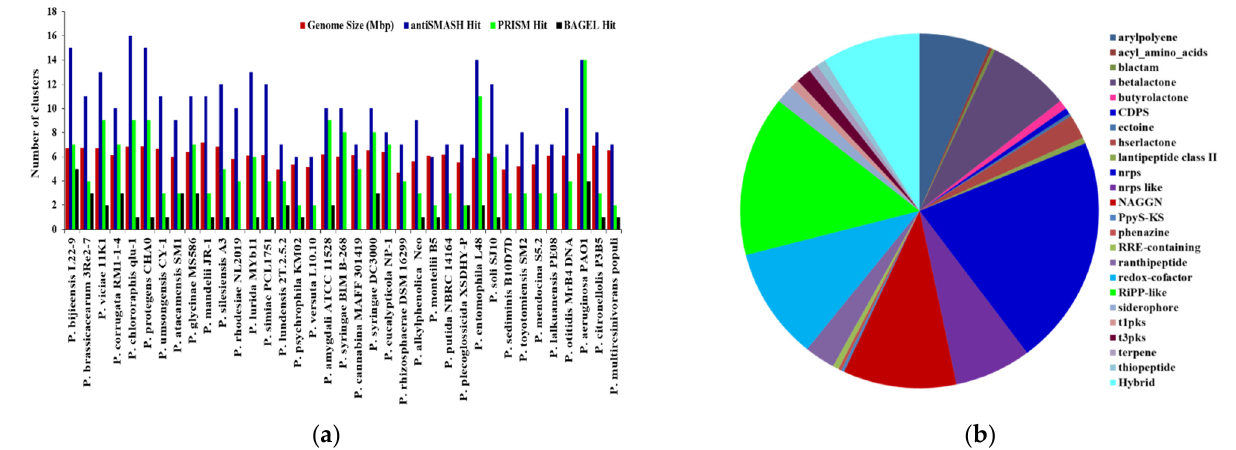
Figure 2. The correlation between genome size and quantity of BGCs on each genome and distributions of major classes of BGCs in Pseudomonas species. ( a ) The number of BGCs per genome mined by different genome mining tools is compared to the size of the genome. ( b ) Distribution of antiSMASH hits of major classes of BGCs.